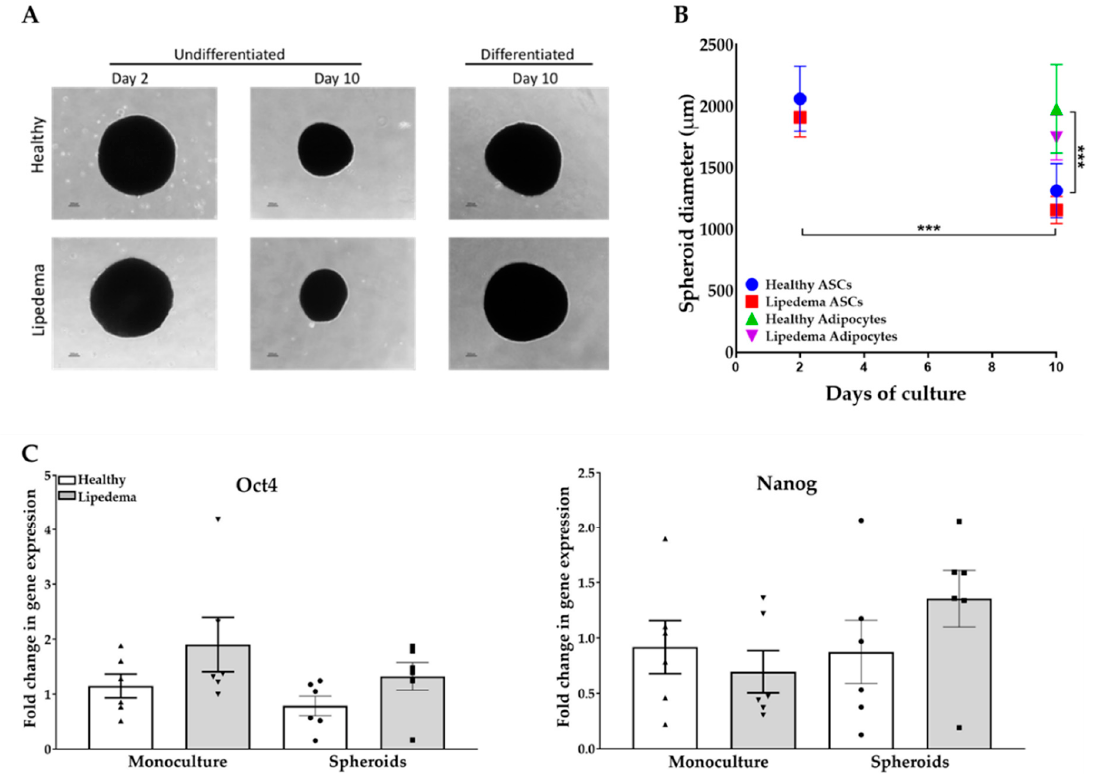
Figure 1. The morphology and the expression of stemness markers of adipose tissue-derived stem cell (ASC) spheroids derived from healthy and lipedema ASCs. ( A ) Representative images of self-assembled ASC spheroids observed by phase contrast microscopy at days 2 and 10 of culture (scale bar, 100 µ m). ( B ) Sizes of spheroids measured using ImageJ software showing a significant reduction in diameter between undi ff erentiated and day ten di ff erentiated spheroids in both groups. Data are shown as mean ± SEM ( n = 7 per group). *** p < 0.001. ( C ) qRT-PCR showing the expression of stemness markers Nanog and Oct 4 in 2D monolayer culture and ASC spheroids at day 10 ( n = 6 per